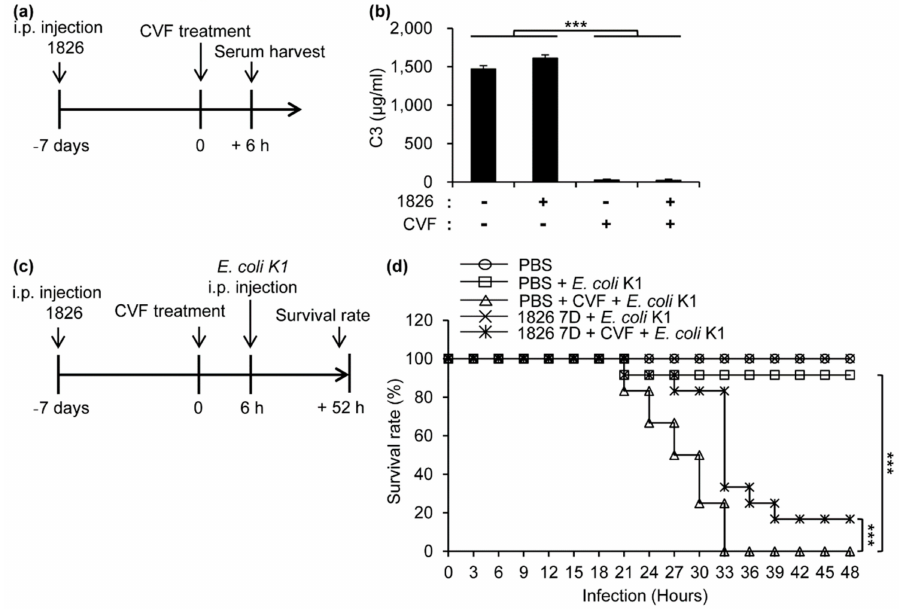
Figure 4. The protective role of complement 3 (C3) induced by CpG-DNA 1826 against E. coli K1 infection. ( a , b ) BALB / c mice were i.p. injected with PBS or CpG-DNA 1826 (2.5 mg / kg mouse). Seven days after the injection, PBS or cobra venom factor (CVF, 30 µ g / mouse) was i.p. injected to remove the C3. After 6 h, the sera were harvested from the mice. ( b ) The levels of C3 in the serum were measured using ELISA kit ( n = 3 / group). ( c , d ) BALB / c mice were i.p. injected with PBS or CpG-DNA 1826. Seven days after the injection, PBS or cobra venom factor (CVF, 30 µ g / mouse) was i.p. injected to remove C3. After 6 h, the mice were i.p. injected with PBS or E. coli K1 (2.5 × 10 5 CFU). ( d ) The survival was monitored for another 48 h after E. coli K1 infection ( n = 12 / group). 1826, CpG-DNA 1826. CVF, cobra venom factor. D, days. *** p <